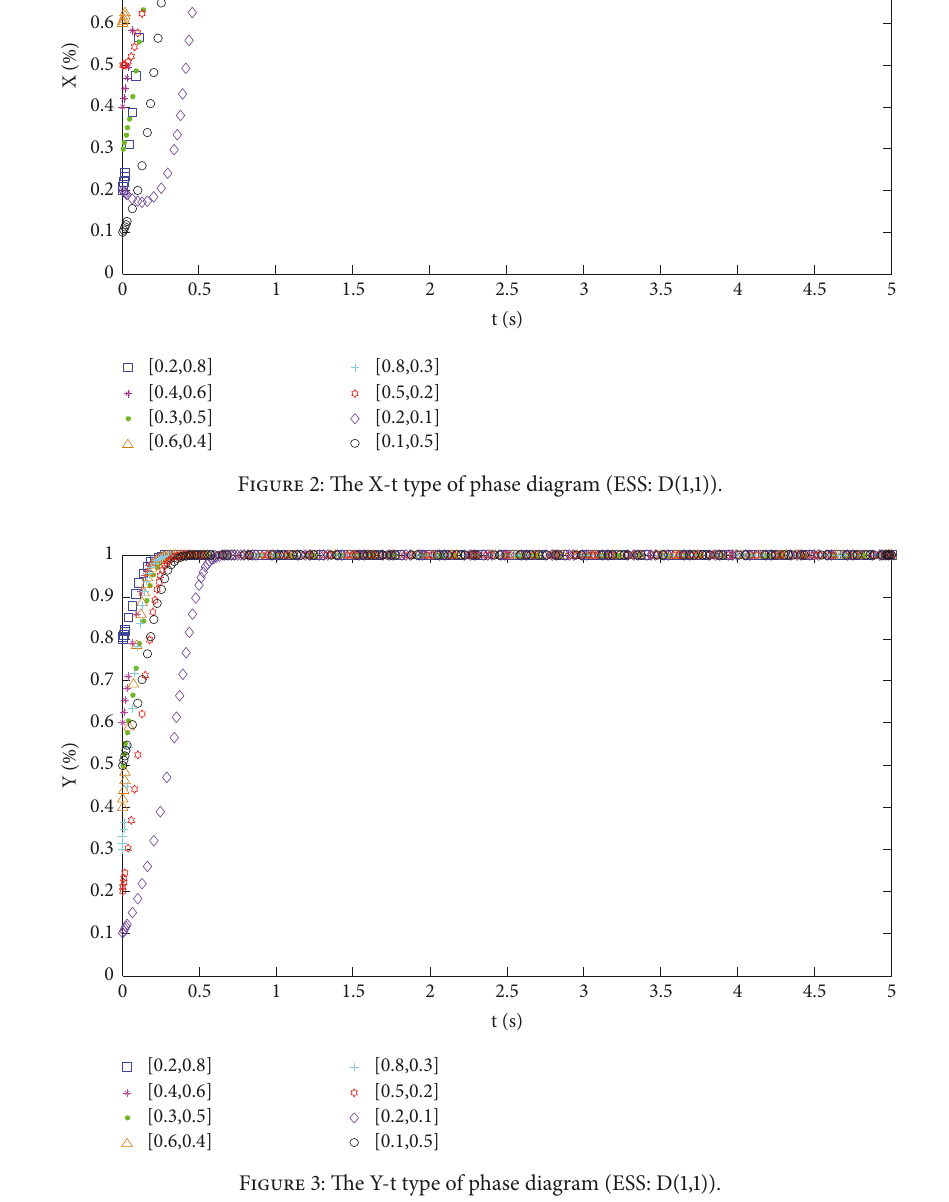
Figure 4 indicated the evolution process and eventual convergence of ( 𝑥 , 𝑦 ) with respect to different initial values of ( 𝑥 , 𝑦 ). The figure showed that when the initial values of ( 𝑥 , 𝑦 ) were treated as (0.2,0.8), (0.4,0.6), (0.3,0.5), (0.6,0.4), (0.8,0.3), (0.5,0.2), and (0.1,0.5); the evolutionary model even- tually converged at equilibrium point D(1,1), while (0.2,0.1) was used as the initial value of ( 𝑥 , 𝑦 ), the evolutionary model converged at equilibrium point A(0,0). This suggested that the evolutionary state of the two players in the